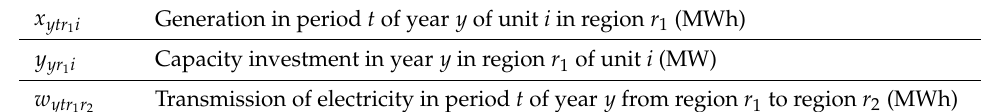
Table 3. GEP Model Decision